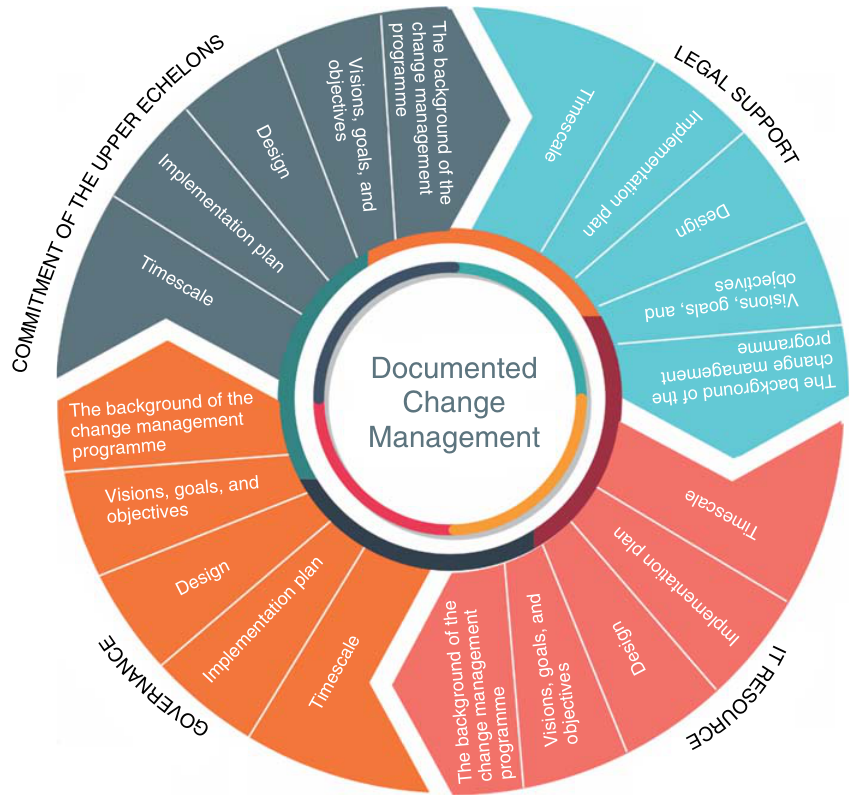
Figure 4. The integration of perceived readiness and documented